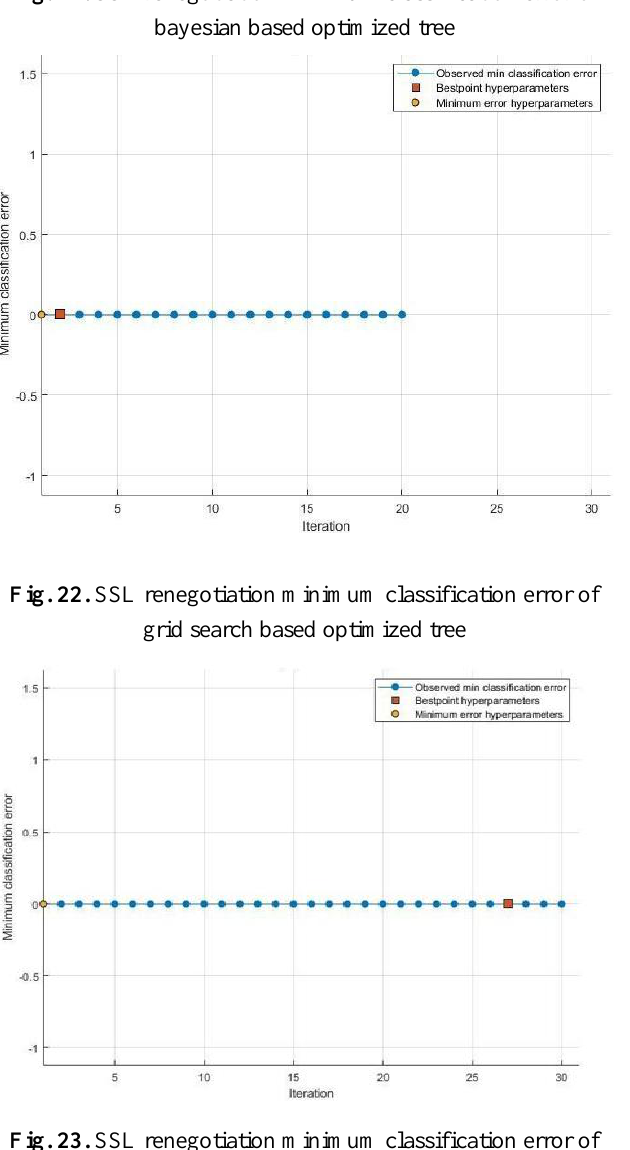
Fig. 23. SSL renegotiation minimum classification error of random search based optimized